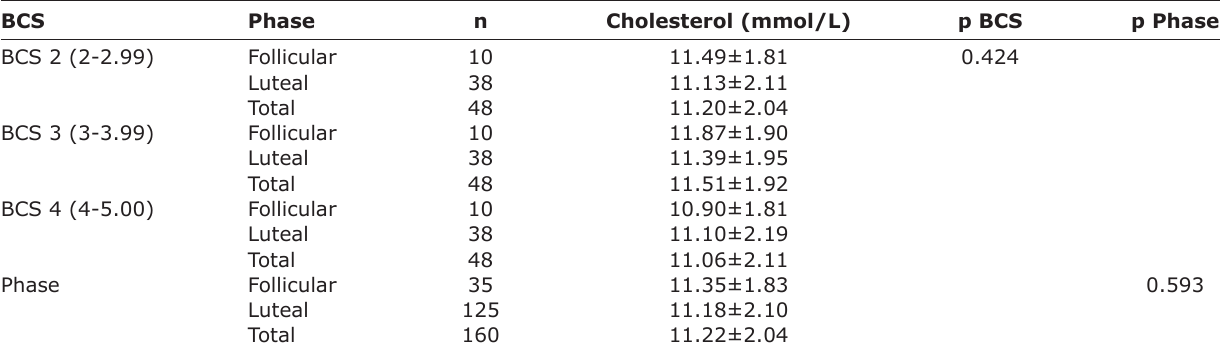
Table-6: Cholesterol levels of Saanen goats in each body condition score during the phases of estrous cycle (mean±SD).